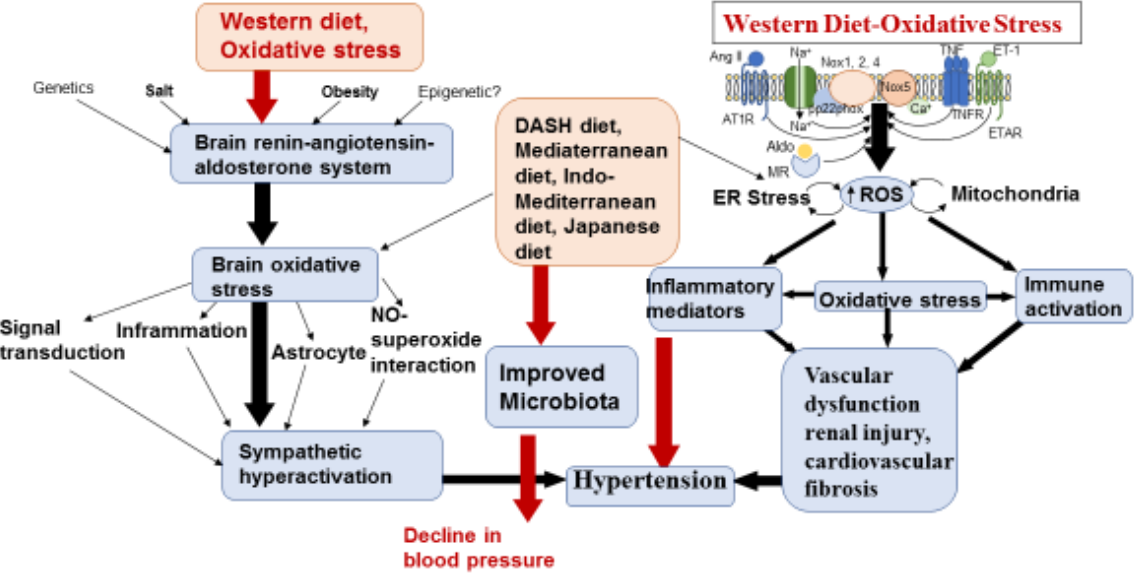
Figure 2. Western diet induced oxidative stress and inflammation causing increase in brain renin- angiotensin-aldosteron system (RAAS) predisposing vascular dysfunctions and